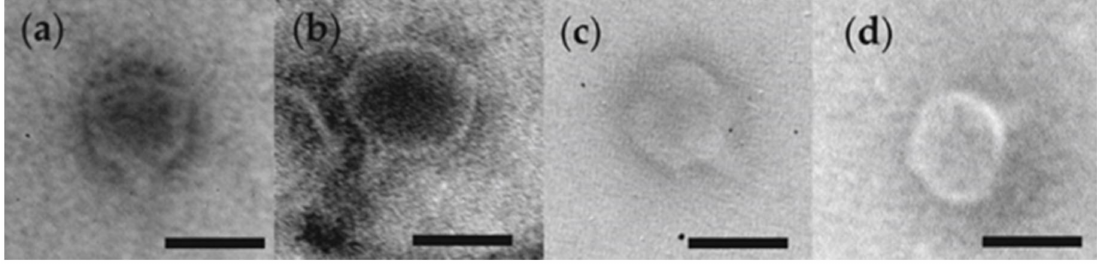
Figure 2. Transmission electron micrographs of fPS-21 ( a ), fPS-7 ( b ), fPS-52 ( c ) and fPS-50 ( d ). The bars indicate 50